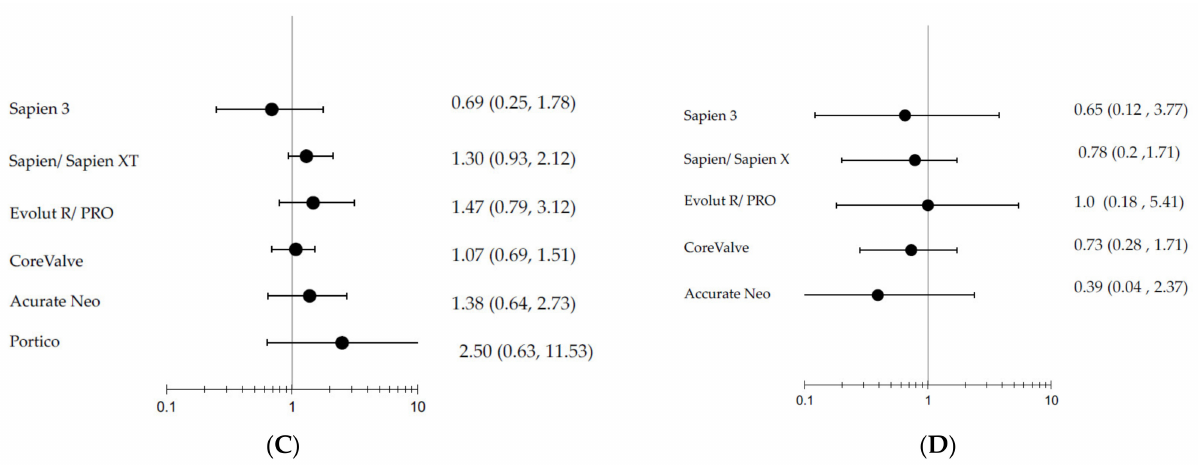
Figure 6. Forest plots of: ( A ) all-cause mortality, ( B ) cardiovascular mortality, ( C ) stroke, and ( D ) aortic regurgitation between various TAVI valves compared to SAVR in randomized controlled